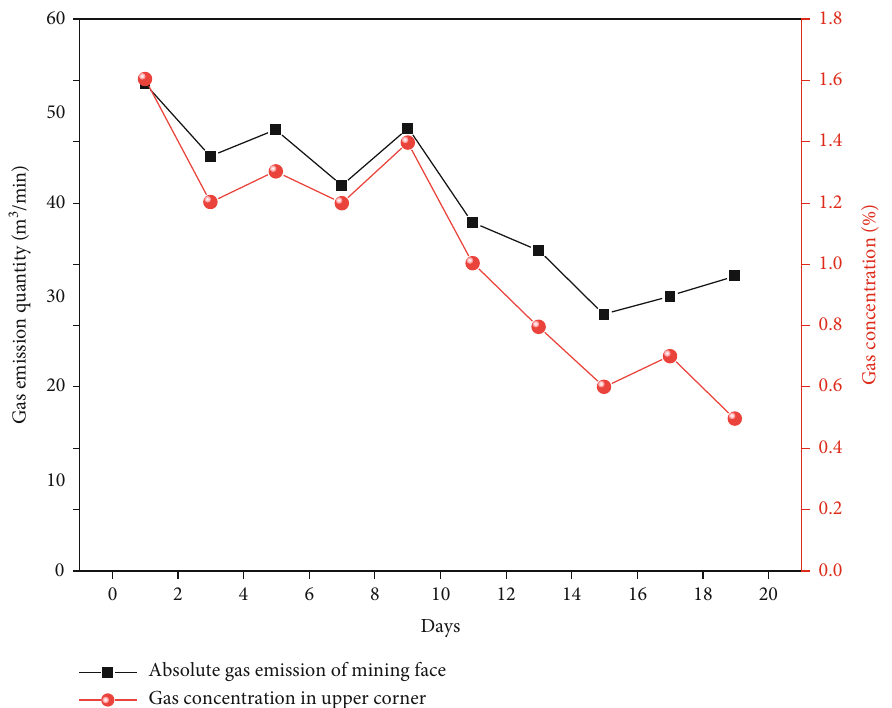
Figure 26: Statistical chart of absolute gas emission and gas concentration in the upper corner of the mining face.